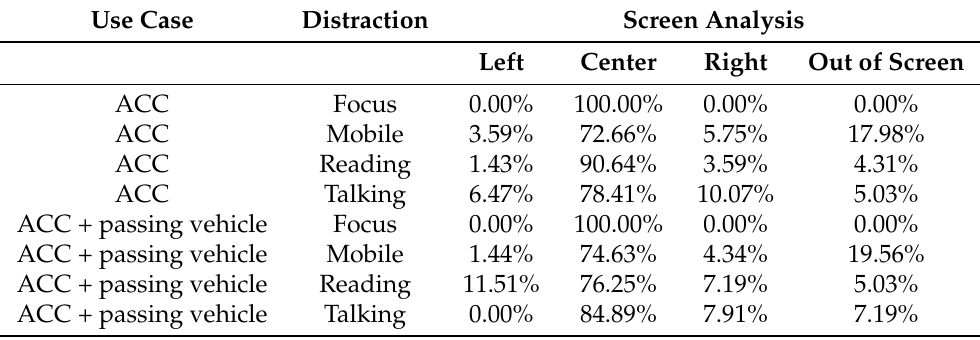
Table 3. Gaze focalization percentage over the three screens during the transition after the take- over